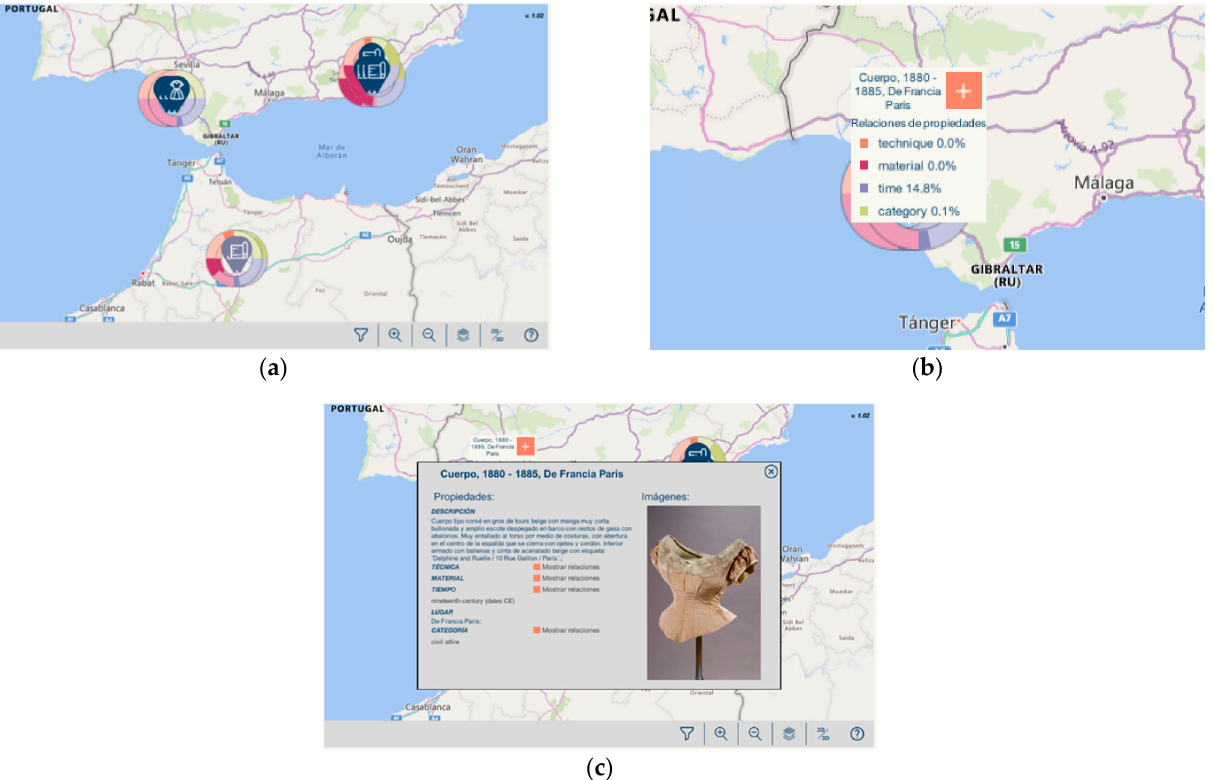
Figure 10. Example of objects with incomplete data, where: ( a ) results of a query in which some ring sections appear with light color; ( b ) depiction of the percentages for each property of an object; ( c ) detail of the object in ( b ).